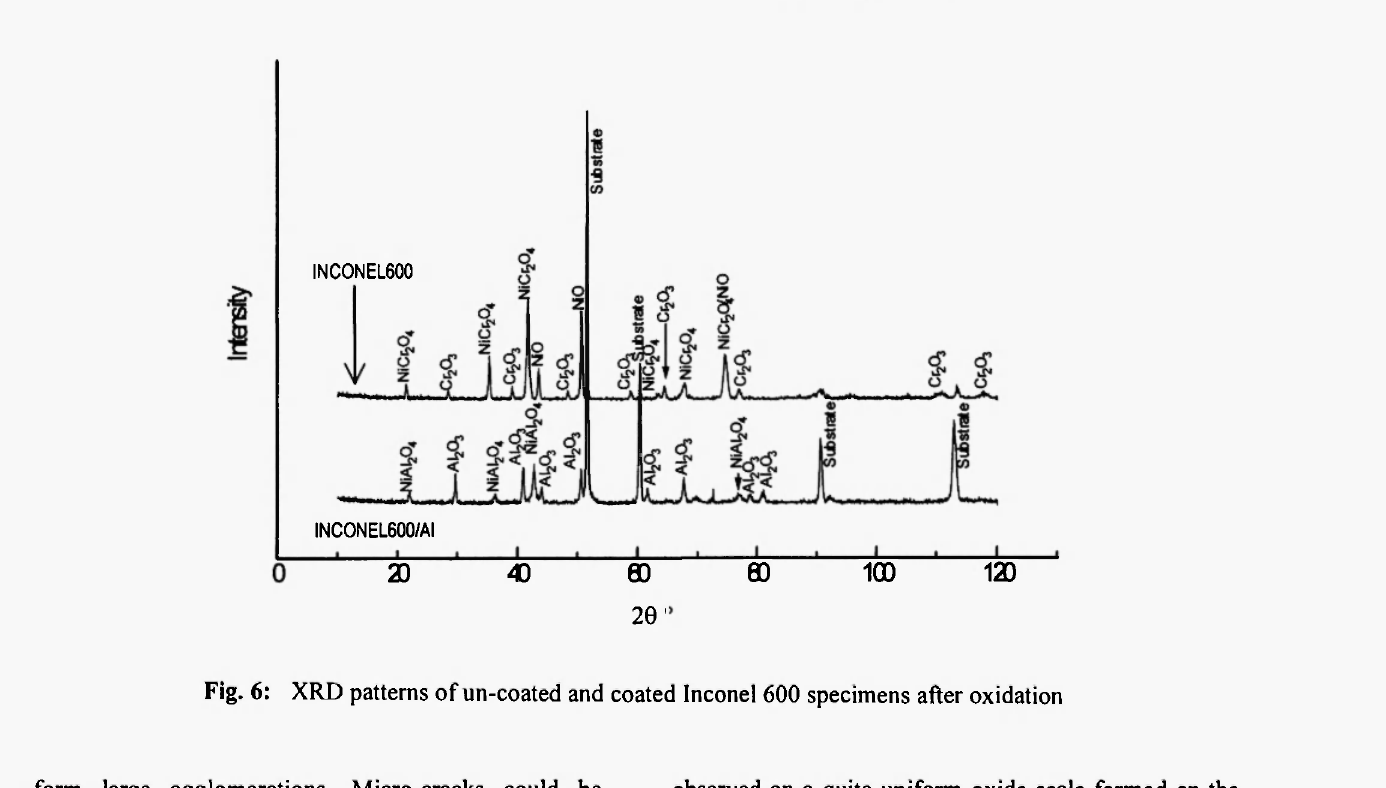
form large agglomerations.